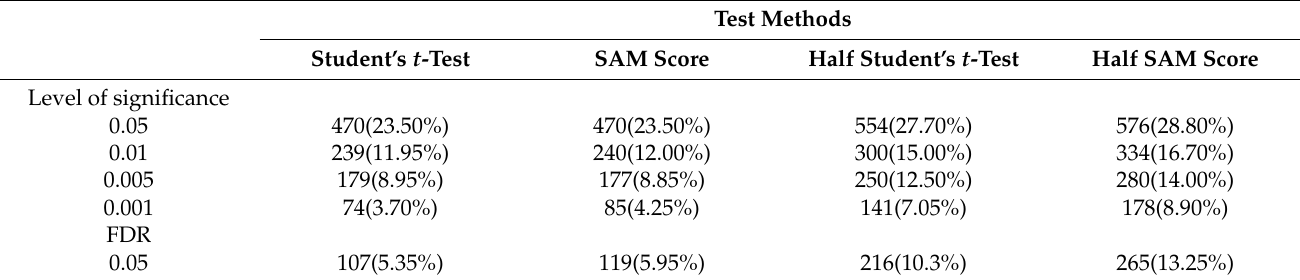
Table 2. Number (percentage) of differentially expressed genes detected by the various test methods in colon cancer data.